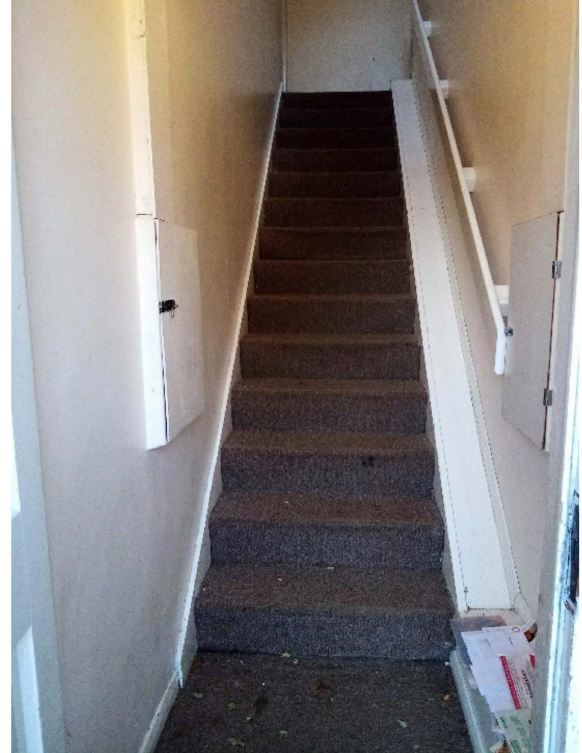
Figure 26. Participant.Survey12.